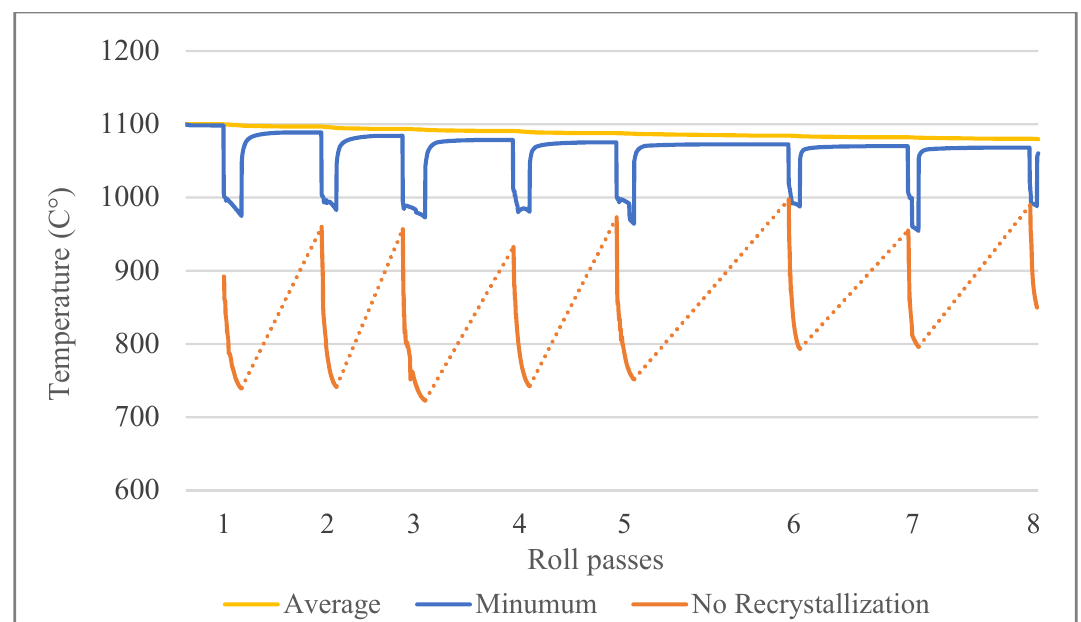
Figure 20. Comparison of estimated no-recrystallization temperature values at each rolling pass with the average and the minimum temperature values.